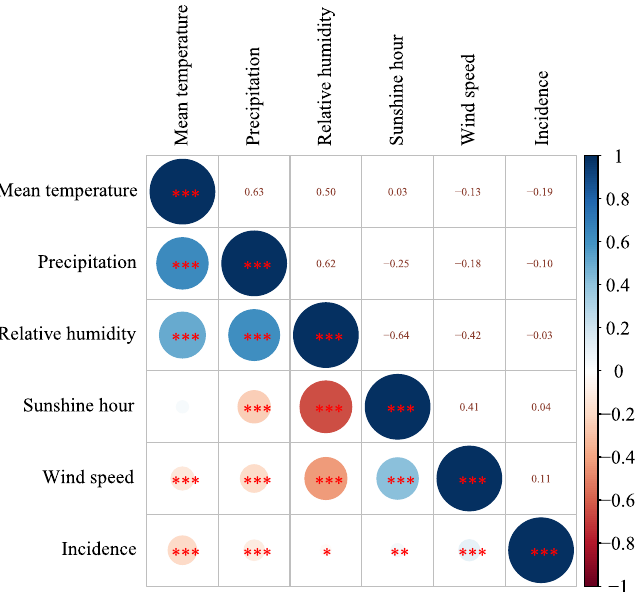
Figure 3. Pearson correlation coefficient between weather conditions and HFRS in China. *0.05 ≥ p > 0.01; **0.01 ≥ p > 0.001; ***≤